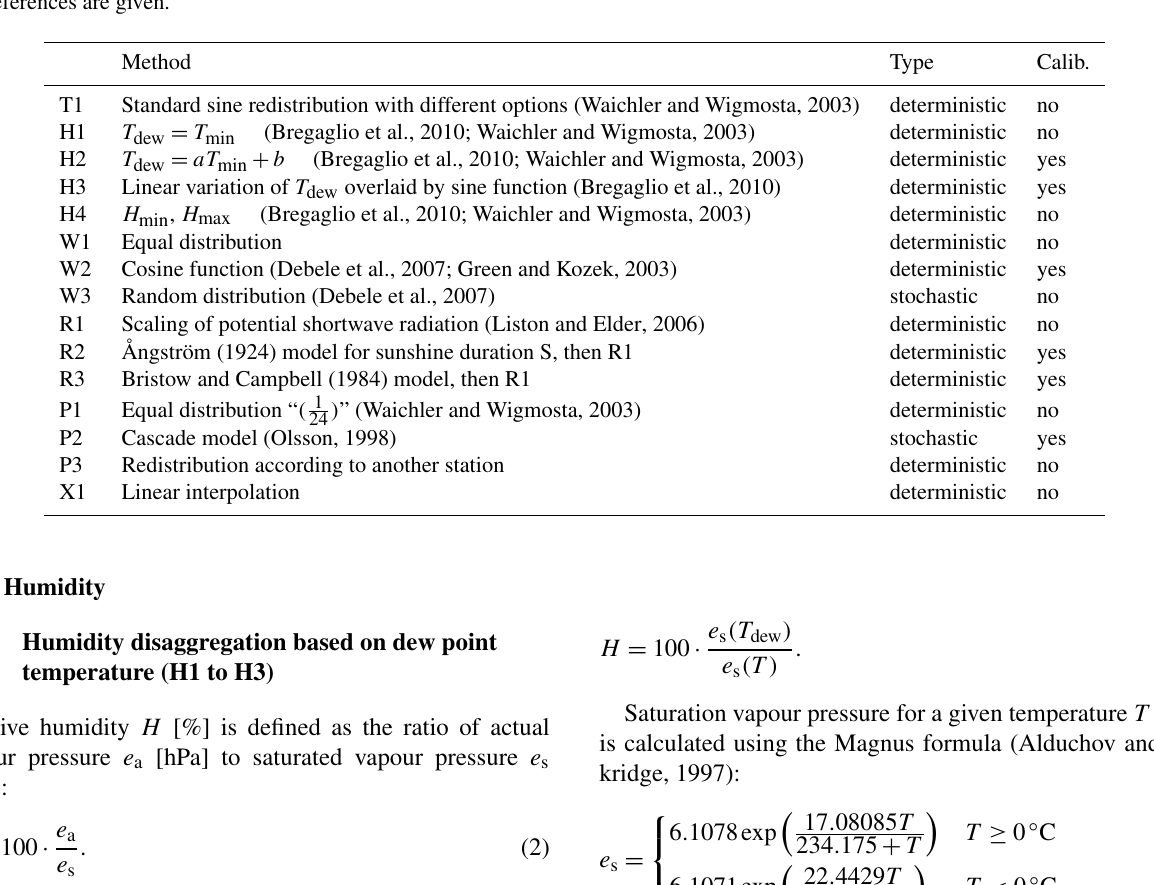
Table 2. Overview of disaggregation methods included in MELODIST. The fist letter indicates the parameter that is considered by each method (P is precipitation, T is air temperature, H is humidity, W is wind speed, R is solar radiation, and X is all variables). For each method, key references are